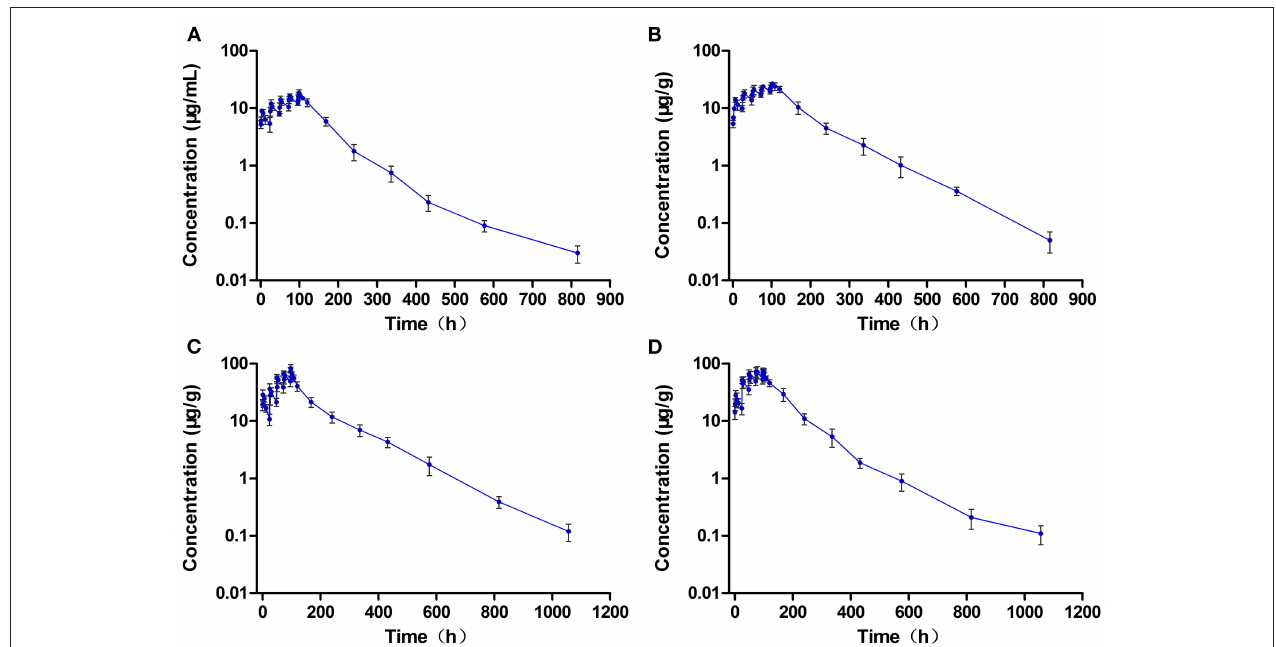
FIGURE 4 | The concentration vs. time curves of enrofloxacin in the plasma (A) , muscle/skin (B) , liver (C) , and kidney (D) of crucian carp during and after multiple oral doses of enrofloxacin (20 mg/kg b.w. daily for 5 days) at 28 ◦ C ( n = 6).